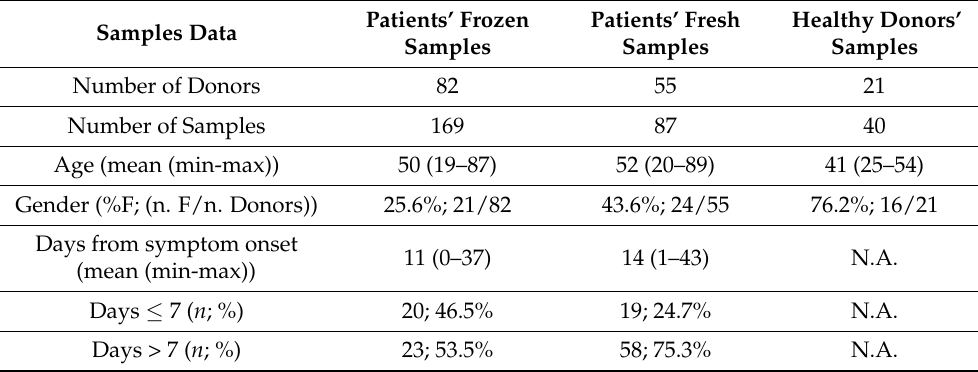
Table 1. Description of saliva samples